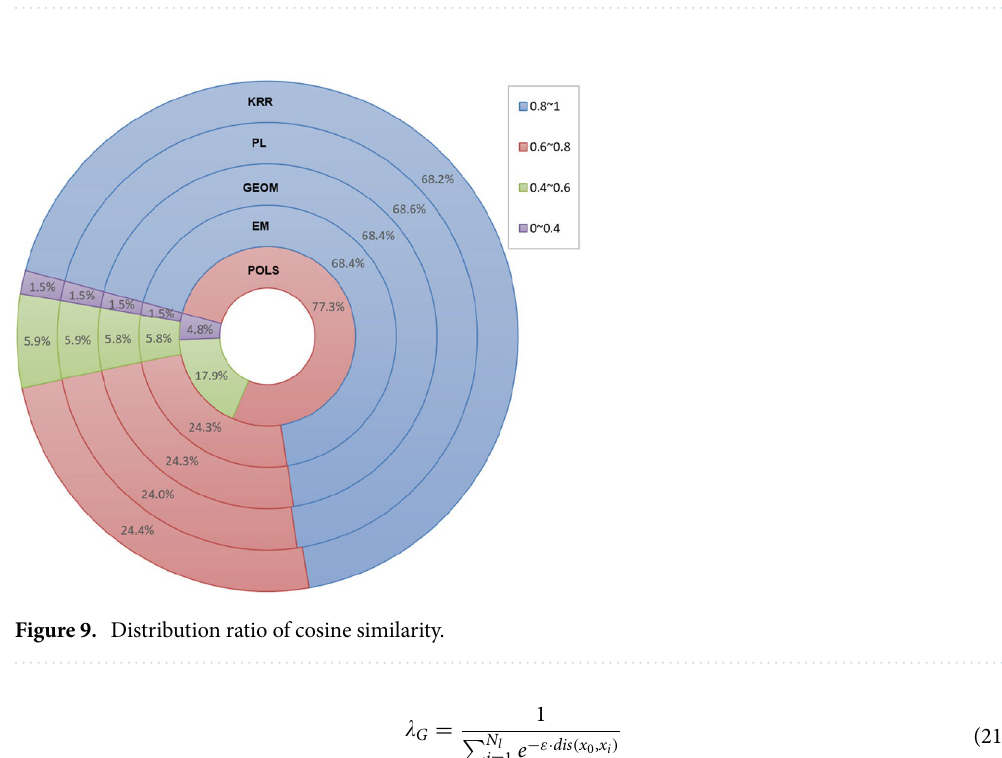
Table 2. Radius of perturbation area vs. privacy parameter ε .